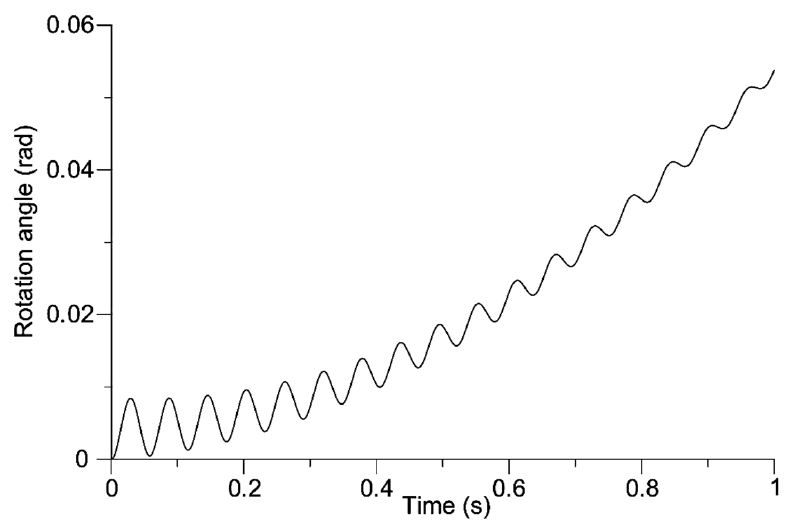
Figure 7. Instant rotation angle of the motion transmission left end in the second experiment t ∈ (0; 1) s.